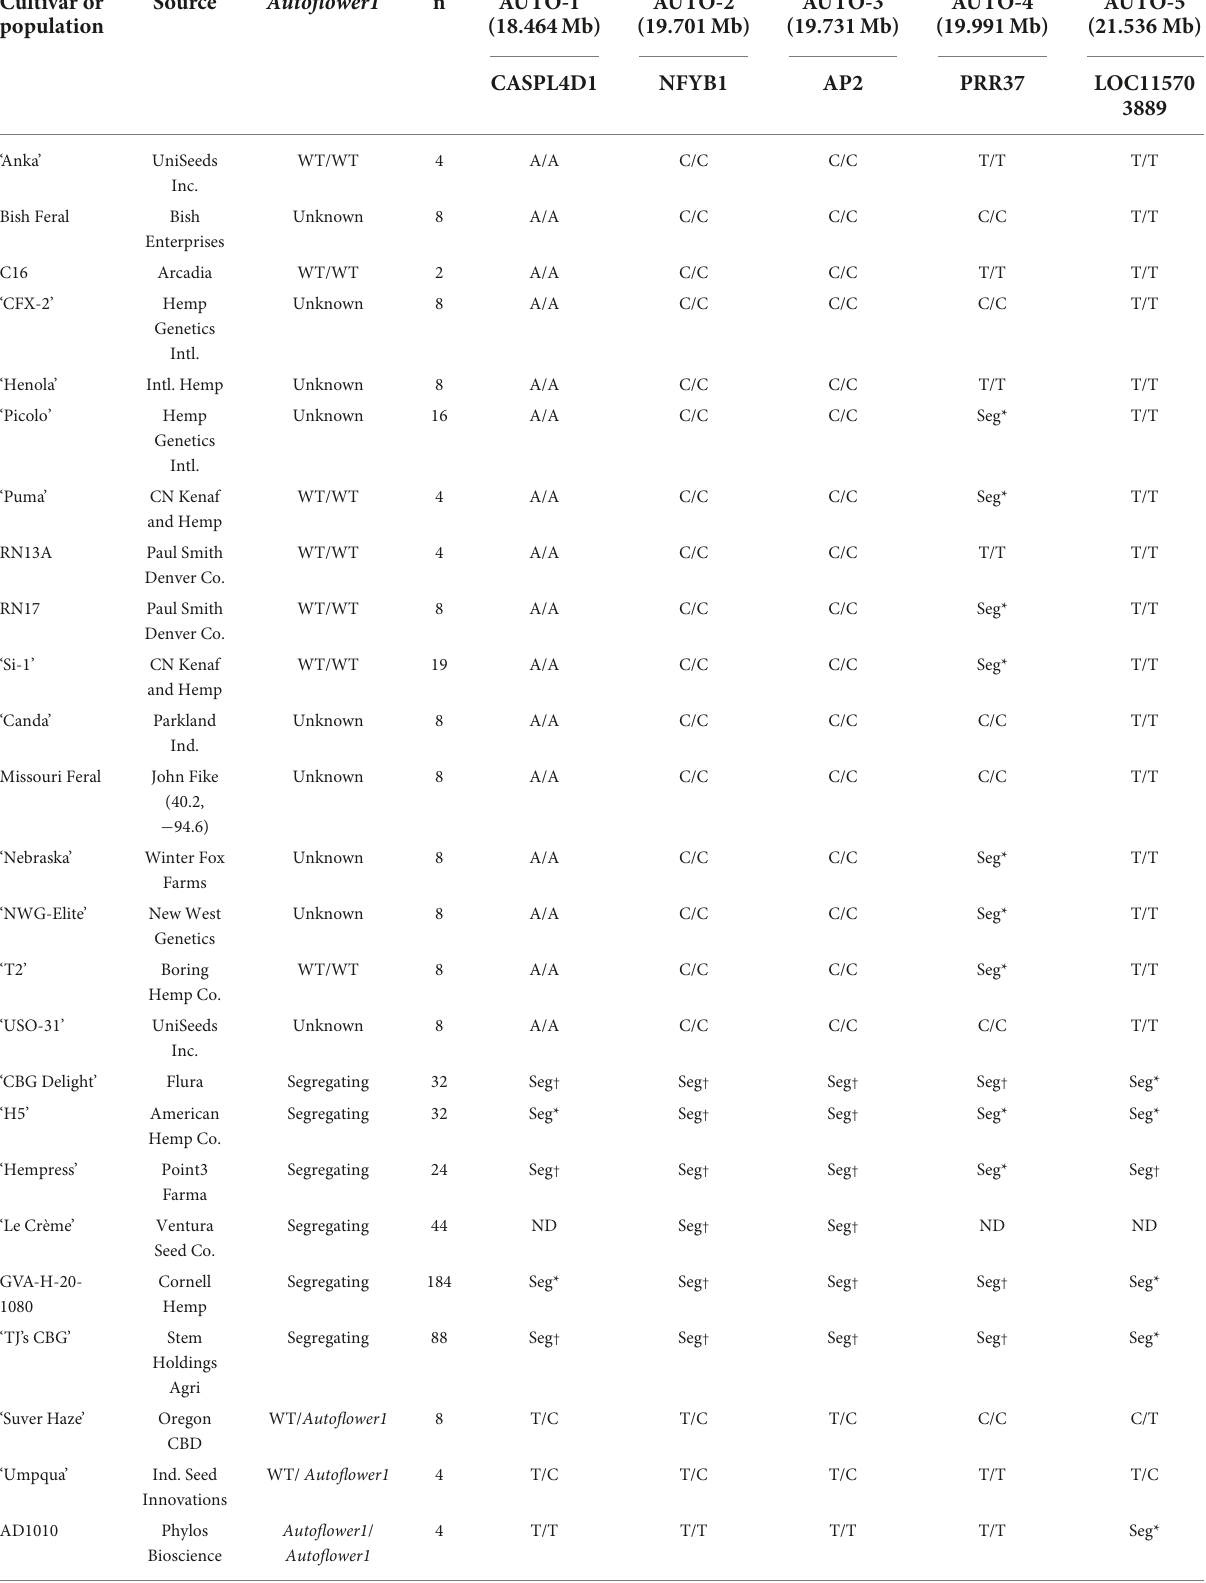
TABLE 2 Genotype group calls for the Autoflower1 locus by cultivar or population. Cultivar or